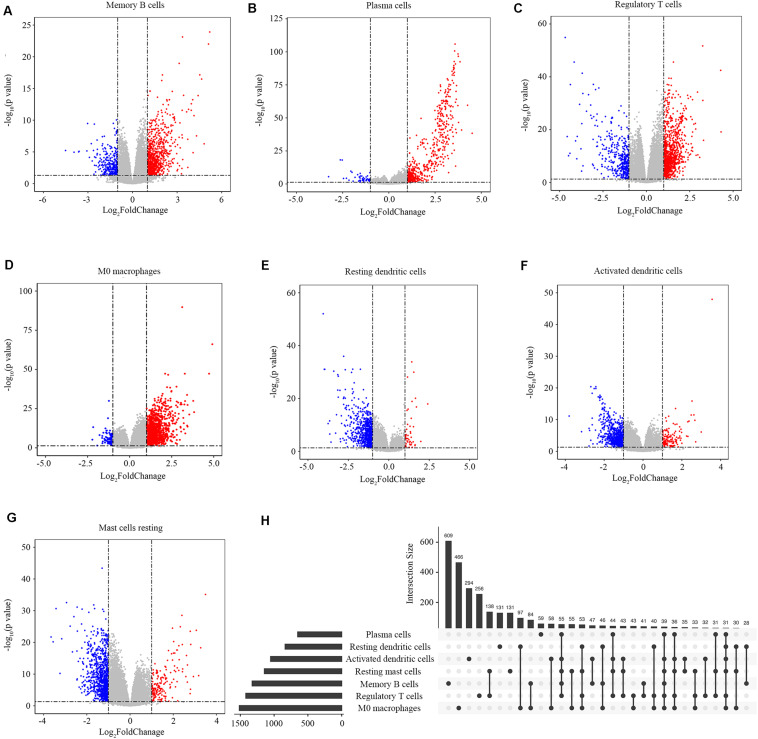
Identification of immune-related genes. (A–G) Gene expression profiles related to memory B cells, plasma cells, regulatory T cells, M0 macrophages, resting dendritic cells, activated dendritic cells, and resting mast cells. Data are presented with Volcano plots. The red/blue dots represent the upregulated/downregulated genes according to the criteria: | log2Foldchange| > 1 and adjusted p-value < 0.05. (H) The distribution of immune-related genes in the seven types of immune cells. Each black dot represents a set of genes that distributed in one type of immune cell. The numbers on the bar represent the counts of genes in this gene set. The dots connected with a black line represent a common set of genes distributed in more than one type of immune cell.